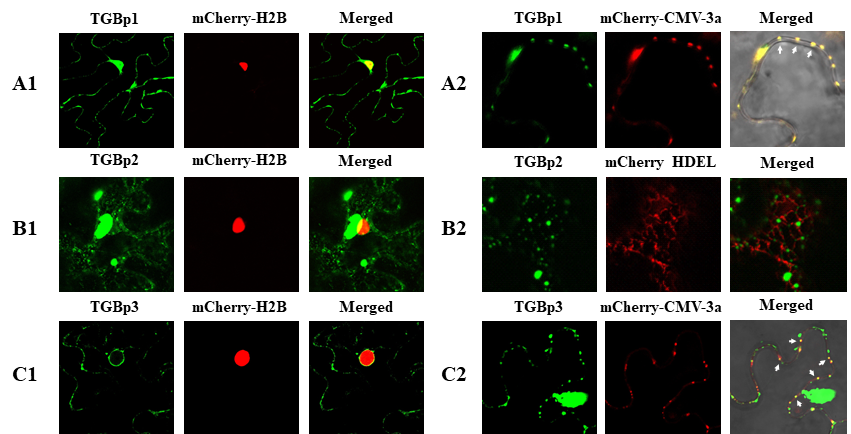
Figure 5. Subcellular localization analysis of CYVCV triple gene proteins (TGBp1, TGBp2 and TGBp3) in N. benthamiana epidermal cells. ( A1 ) and ( A2 ) Colocalization of CYVCV-TGBp1 with mCherry-H2B and mCherry-CMV3a at the nucleus and PD. ( B1 ) and ( B2 ) Colocalization analysis of CYVCV-TGBp2 with nuclear marker mCherry-H2B and ER marker mCherry-HDEL. ( C1 ) and ( C2 ) Colocalization of CYVCV-TGBp3 with mCherry-H2B at the nuclear membrane (perinucleus) and plasmodesmata (PD). Arrows indicated discontinuous punctate spots where CYVCV TGBp1 and TGBp3 colocalized with PD marker mCherry-CMV-3a. Photos were taken at 48 h post infiltration (hpi).